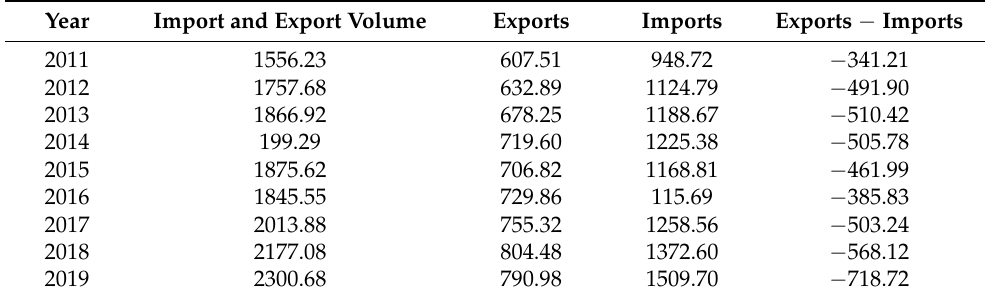
Table 4. Changes in Foreign Trade of Agricultural Products in China from 2011 to 2019 (billion USD) 1 .